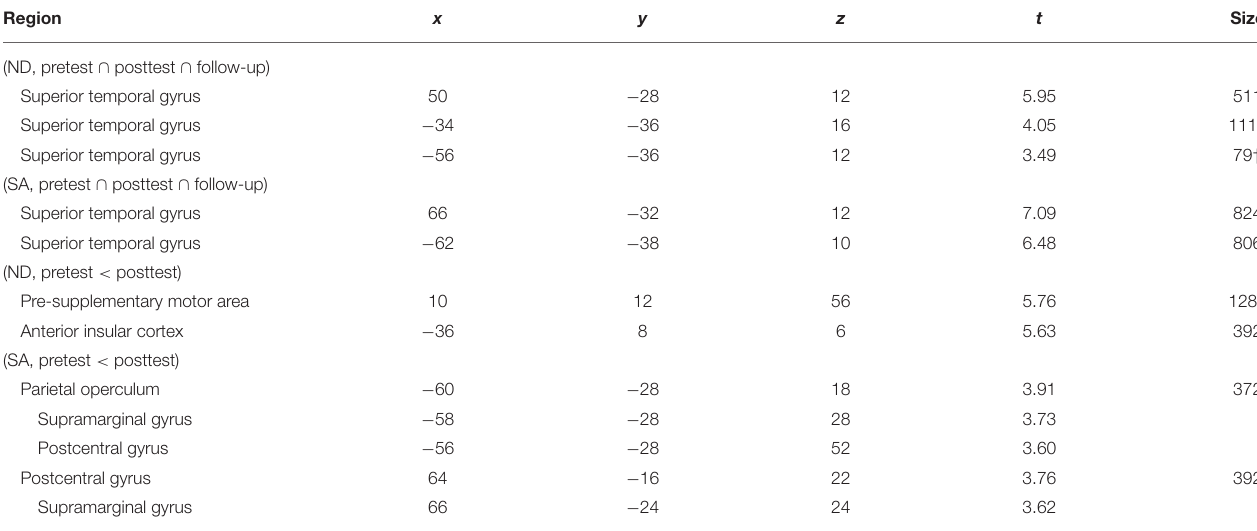
TABLE 1 | Brain regions activated in response to auditory cues for self-localization. Region x y z t Size (ND, pretest ∩ posttest ∩ follow-up)